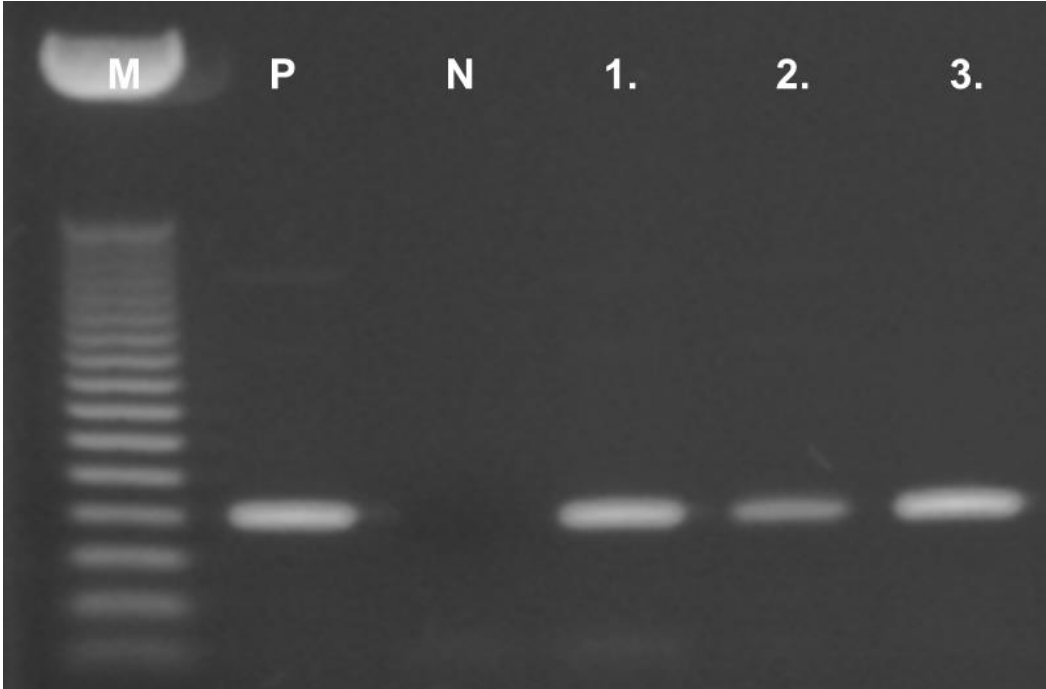
Figure 2. A representative figure of the expression of β-actin housekeeping gene in pediatric hematological and oncological specimens. M: DNA marker (50 bp); P: positive control (human pituitary); N: negative template control; 1–3: Representative pediatric samples.